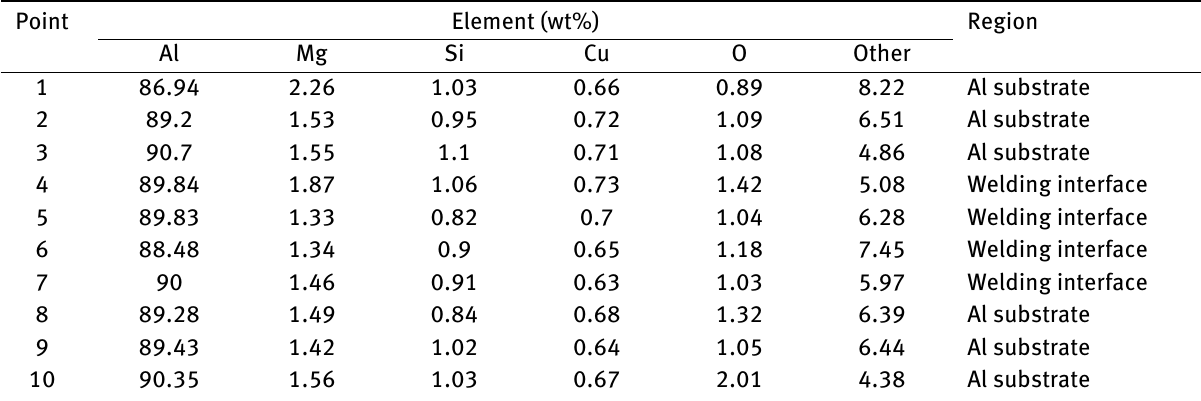
Table 4: Chemical spot analysis result at the interface of W7 P-FSSW joints